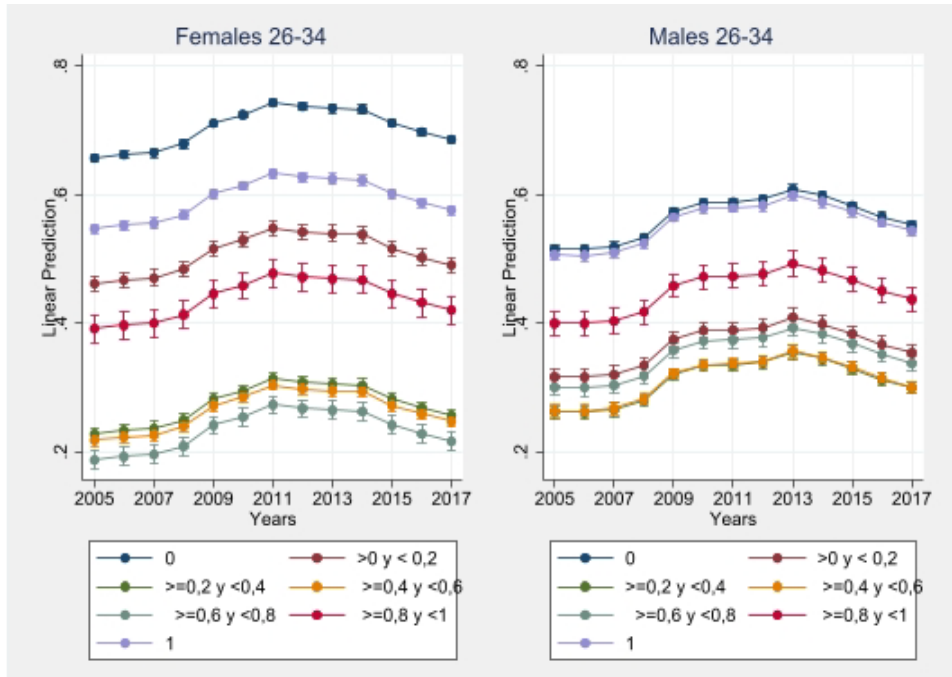
Figure 7 : Predicted probability of youth between 26-34 years of age living out of the parental home by gender and other household members’ employment deprivation situation.